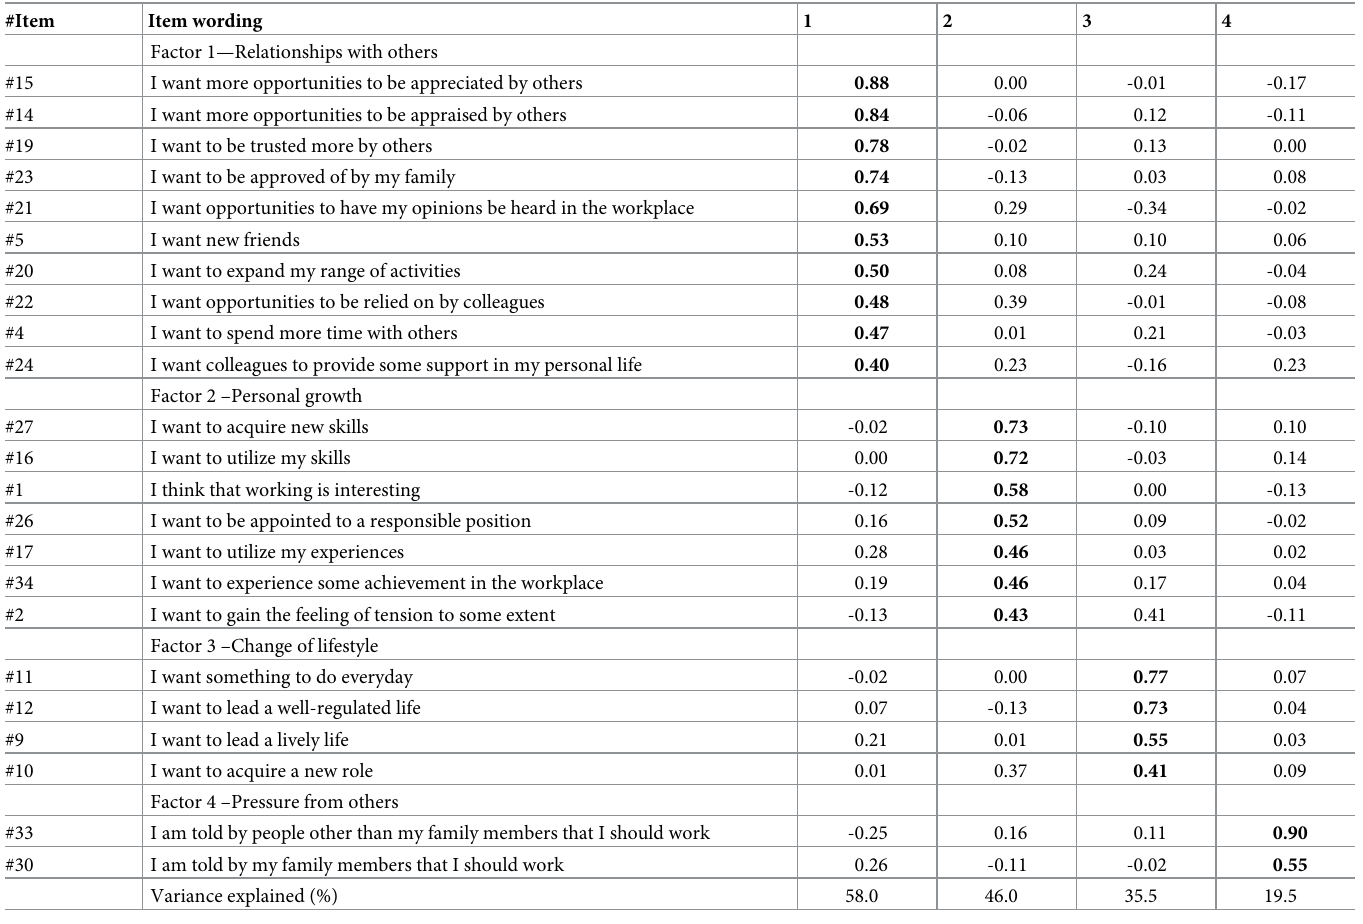
Table 2. Rotated factor loadings and percentage variance explained (N =